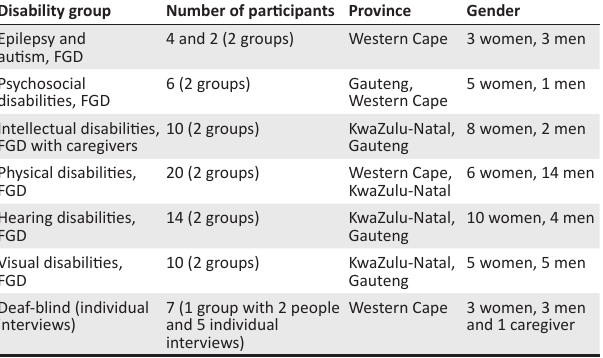
TABLE 1: Participants in focus group discussions. Disability